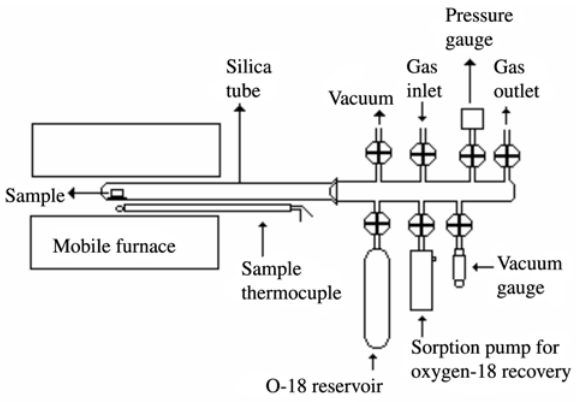
Figure 1. Schematic diagram othe heat treatment arrangement used for diffusion experiments by the isotope exchange